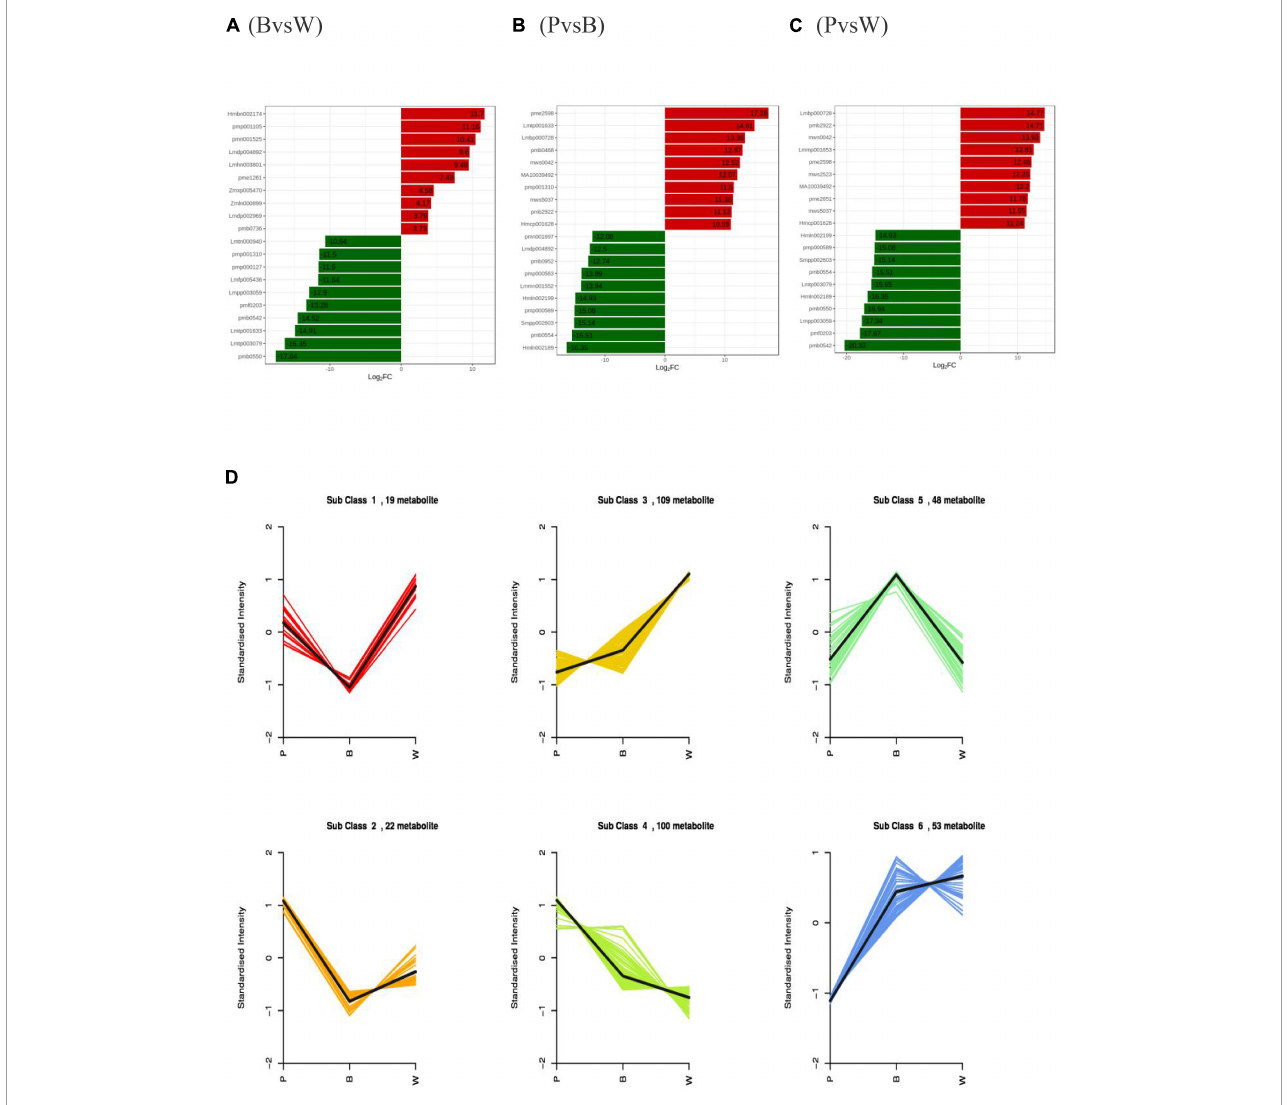
FIGURE3 Differential metabolites profiles (A) Multiple histograms for blue and white wheat grains. (B) Multiple histograms for purple and blue wheat grains. (C) Multiple histograms for purple and white wheat grains. (D) K-means clustering. Metabolites with the same relative content variation trend in different lines were classified into one